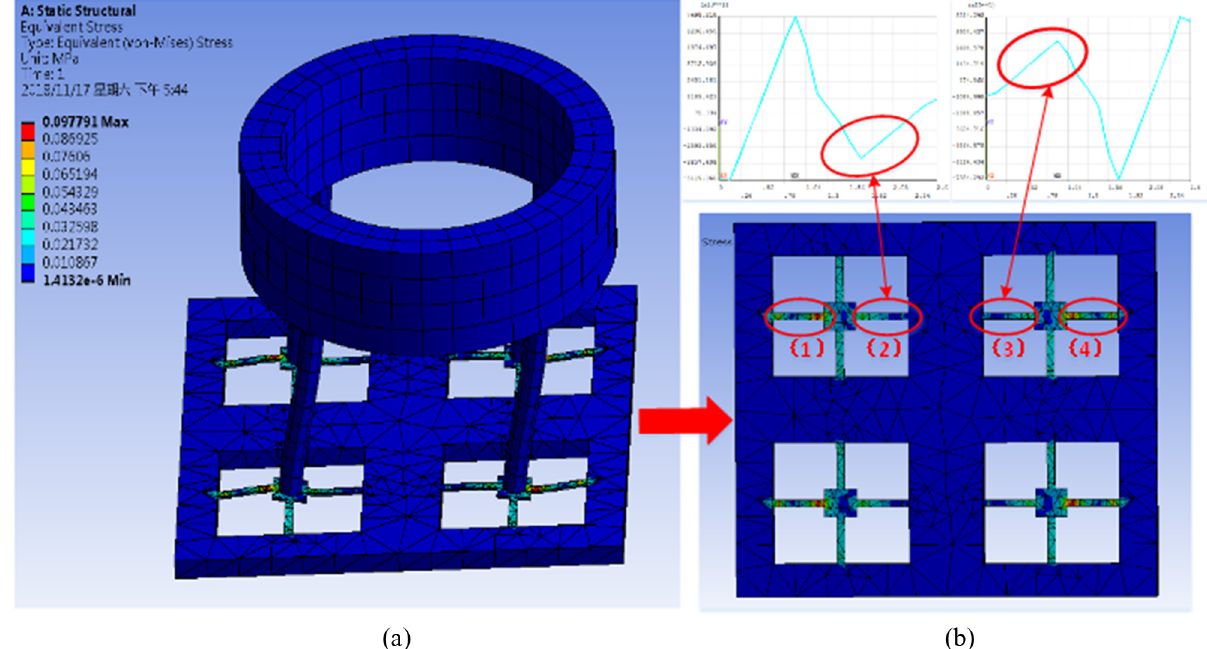
Fig. 9. Stress nephogram and stress curves of AFUVH. (a) Stress nephogram (b) Stress curves of the cantilever beams.